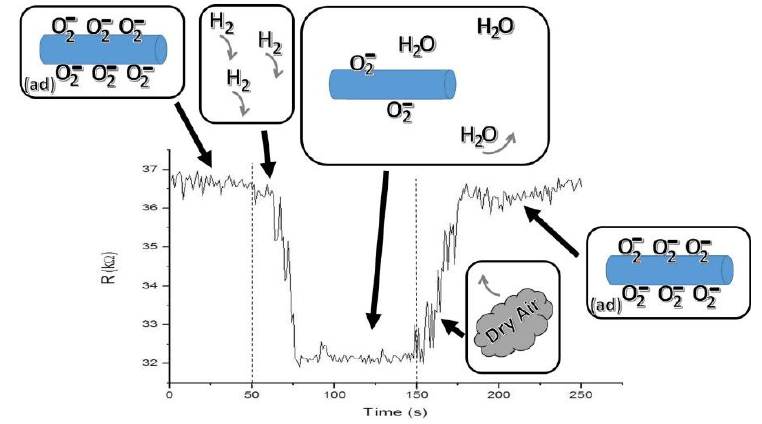
Figure 3. Sensing mechanism scheme occurring in one of the semiconductor devices, through the resistance change of M 2 at a pulse concentration of 121 ppm of H 2 at